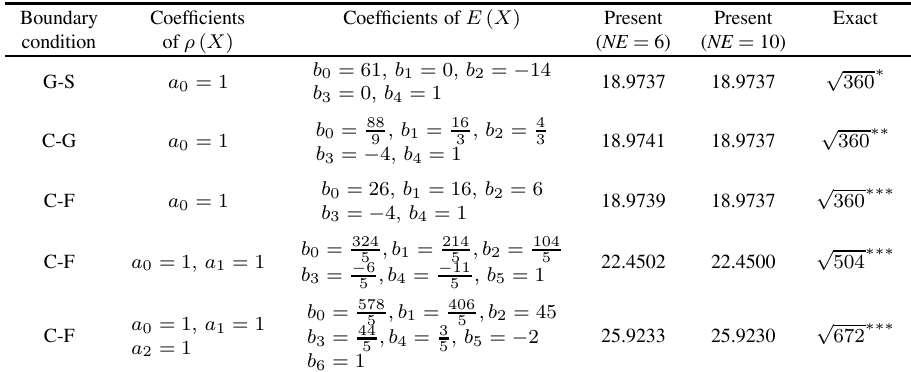
Table 4 Fundamental transverse frequency of an axially FG uniform beam